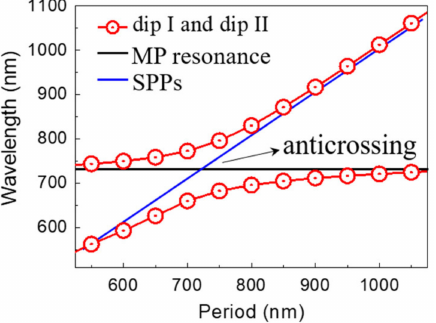
Figure 4. The dependence of the reflection dip positions (I) and (II) on the period P . The positions of the MP resonance (solid black line) and the SPPs (solid blue line) are also